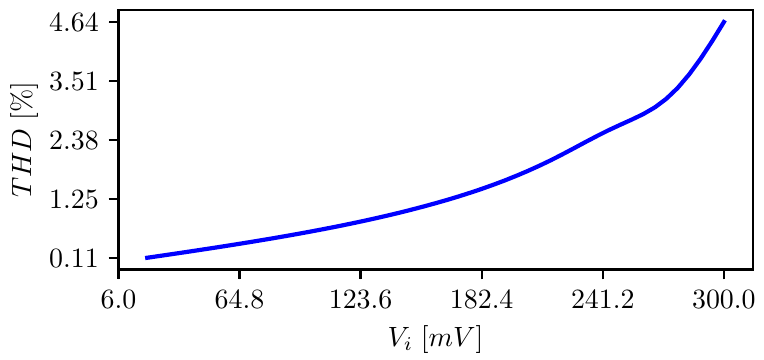
Figure 14. Total harmonic distortion vs. input amplitude for a 200 Hz sinusoidal input in unity- gain configuration.